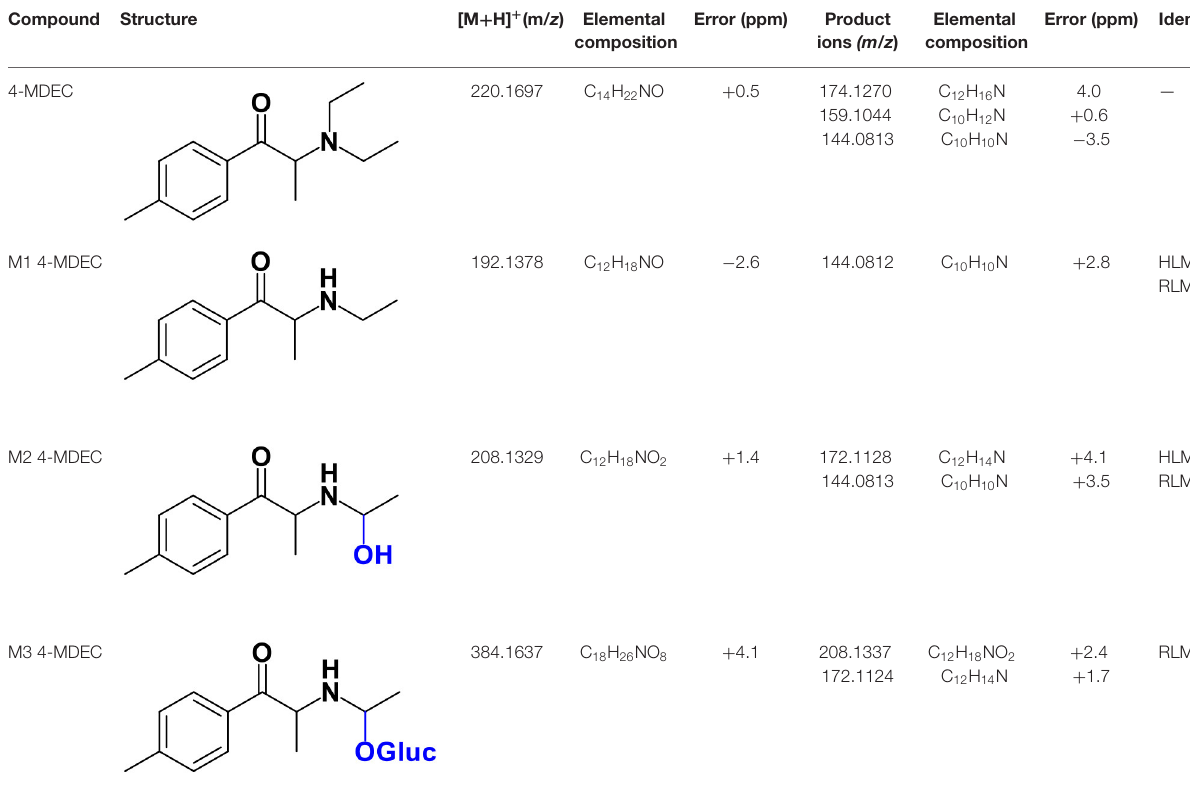
TABLE 4 | Structures of the 4-MDEC metabolites identified in HLM and RLM incubations by LC-HRMS/MS (ESI + ) analysis. Compound